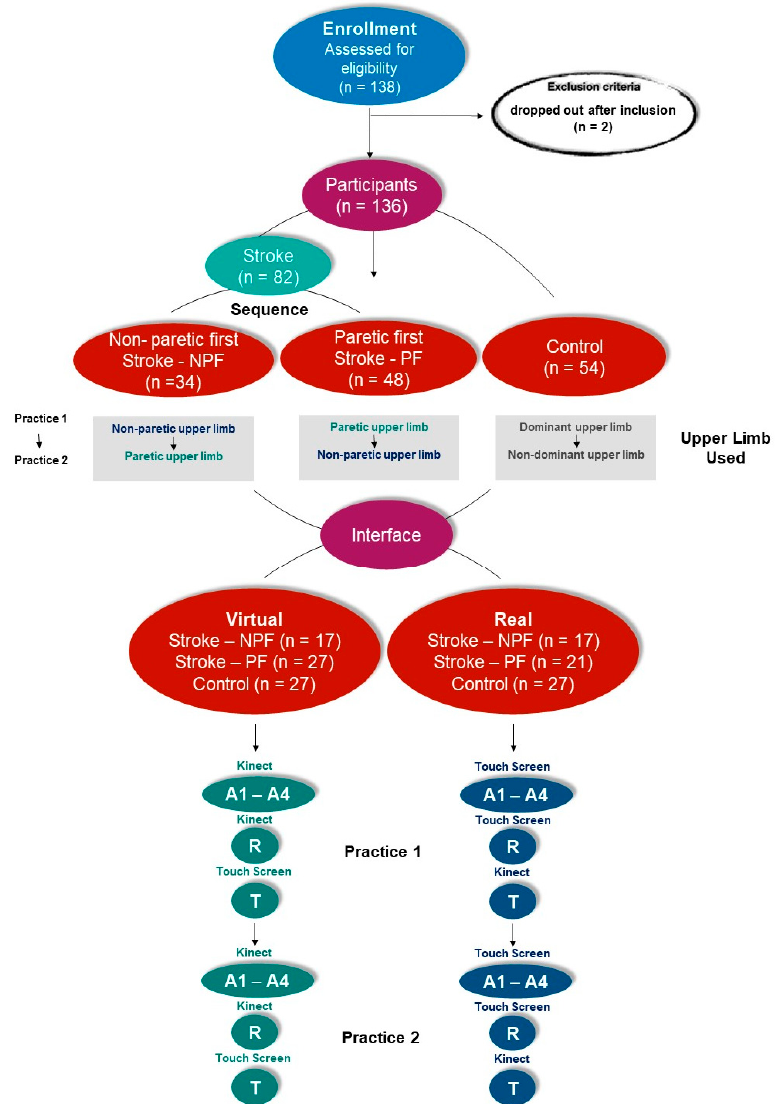
Figure 2. Flowchart of protocol sequence and groups. NPF: Non-paretic first; PF: Paretic first; A1–A4: Acquisition blocks; R: Retention block; T: Transfer block.